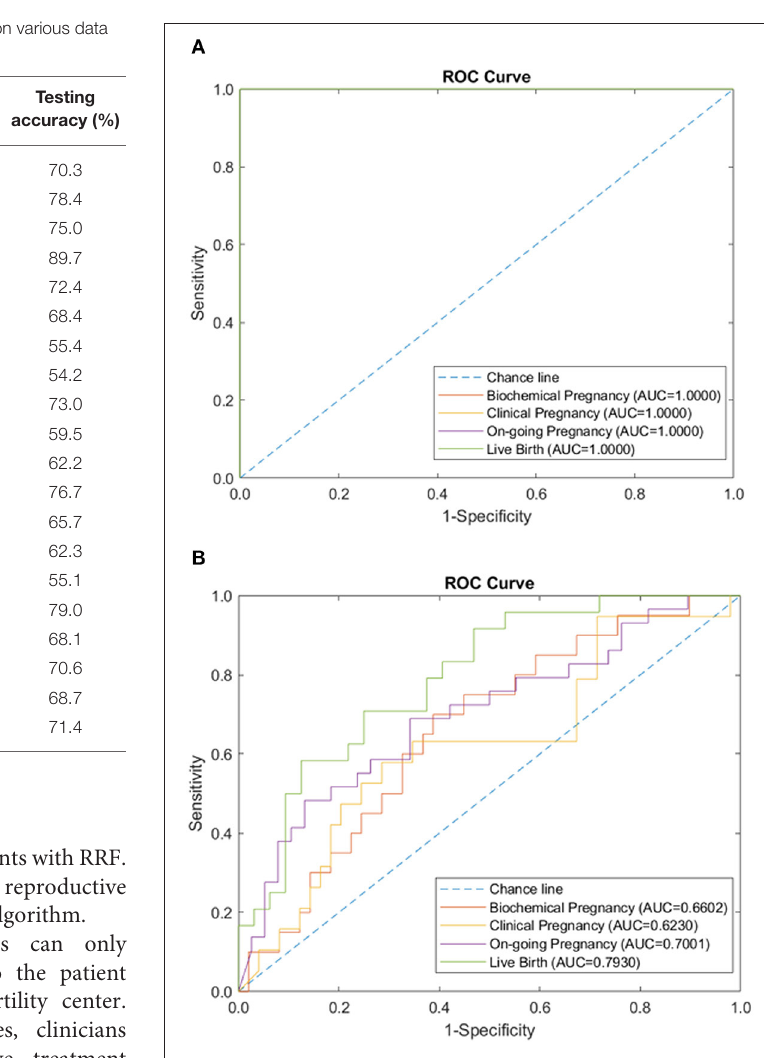
FIGURE 5 | Combination of immunology and IVF-related panels (autoantibodies, peripheral immunology, endometrial immunology, basic patient characteristic, hormone level, and embryo parameter) performance of sparse coding in predicting pregnancy outcomes at different pregnancy periods. (A) ROC plot of the training data set. (B) ROC plot of the testing data